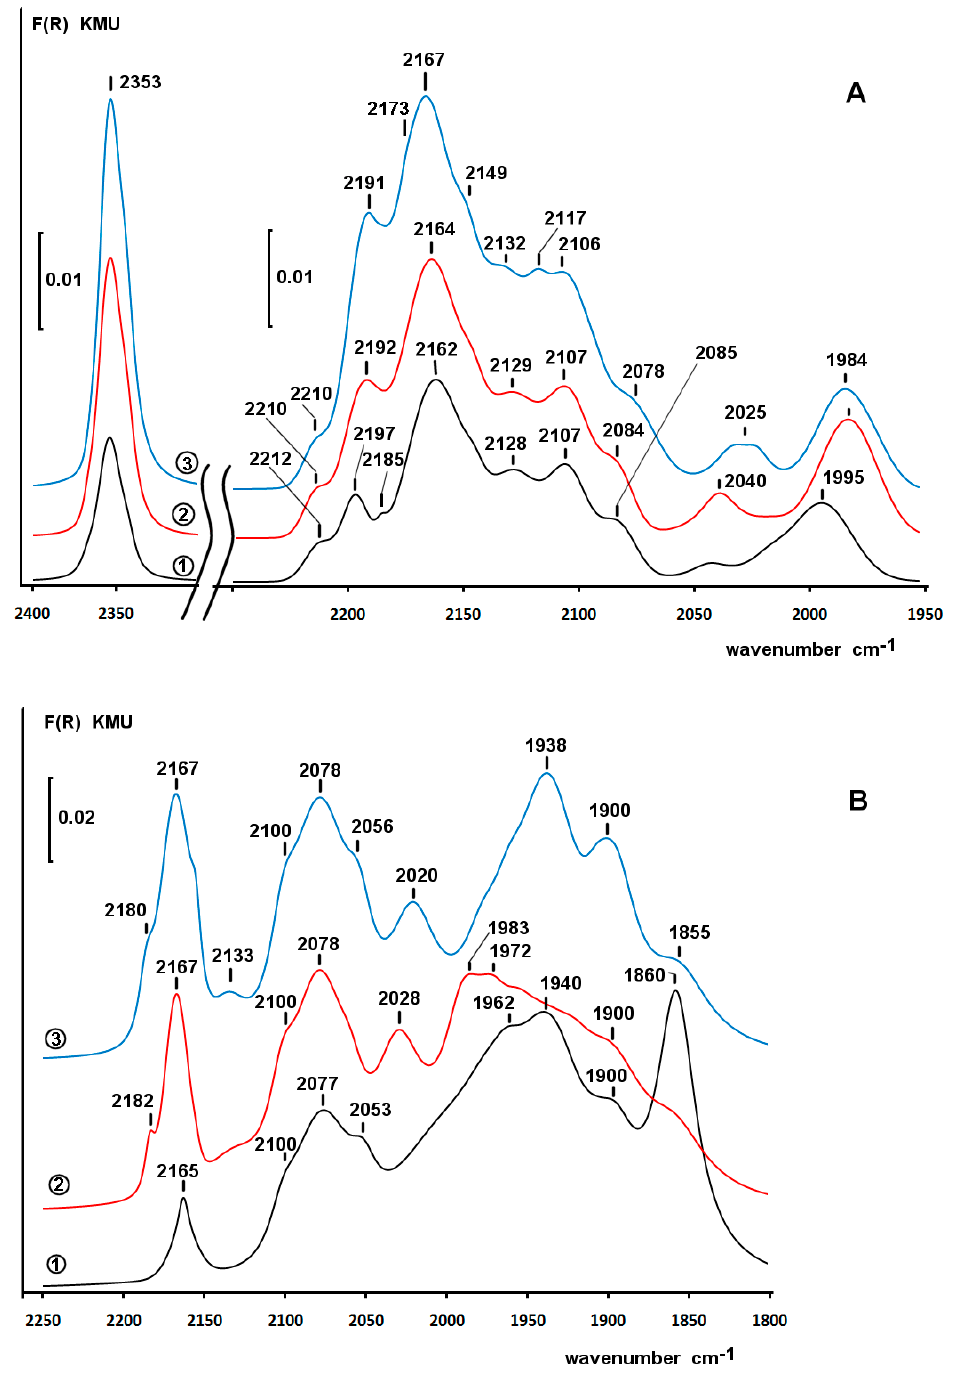
Figure 7. Difference DRIFT spectra of CO adsorbed at room temperature on the FePd/ZS(550) before ( A ) and after H 2 treatment ( B ). CO pressure: 5 Torr—curve 1; 20 Torr—curve 2; 50 Torr—curve 3. F(R)—Kubelka–Munk function (Kubelka–Munk Units).